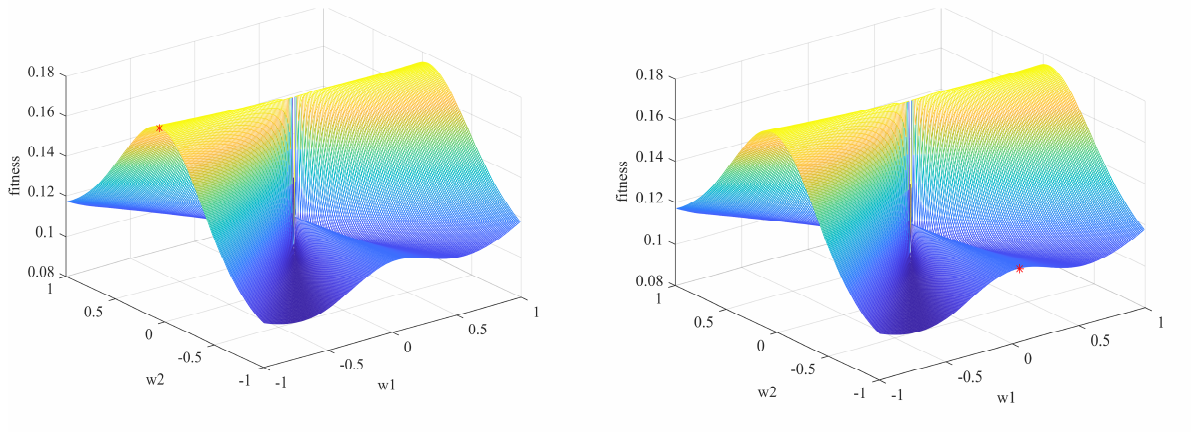
Figure 4. The optimum fitness range of y 1 and y 2 using the symmetric matrix. The red dots represent the best fitness values at w position, which was searched by the swarm intelligence algorithms. When [ w 1 , w 2 ] is [ − 1, 0.05] searched by SI, y 1 ( t ) reached the fitness of 0.18; When [ w 3 , w 4 ] is [0.05, − 1] searched by SI, y 2 ( t ) reached the fitness of